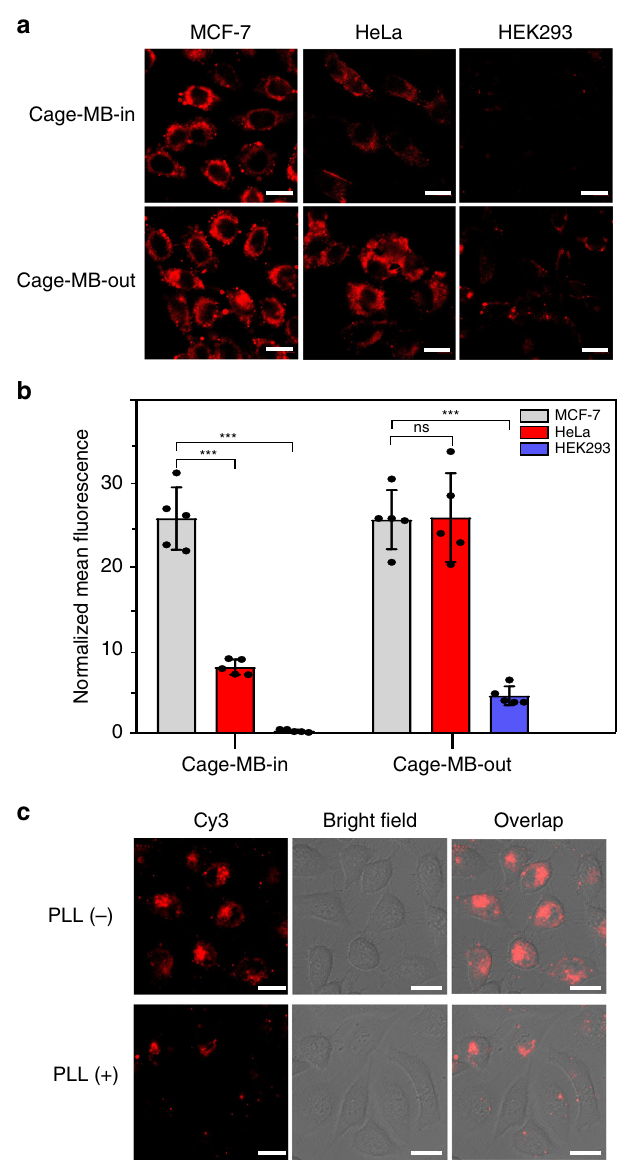
Fig. 7 Size-selective discrimination between mature microRNA and precursor microRNA in living cells. a , b Fluorescence confocal imaging of MCF-7, HeLa and HEK293 cells incubated with 100 nM Cage-MB-in and Cage-MB-out ( a ) and the normalized mean fl uorescence by ImageJ ( b ); Data are presented as mean values ± s.d. ( n = 5), *** p = 0.00000068 (0.000000036), 0.0000014 for HeLa (HEK293) to Cage-MB-in, HEK293 to Cage-MB-out < 0.001, ns = 0.93 > 0.05 (not signi fi cant), by two-tailed unpaired Student ’ s t -test. c Fluorescence confocal imaging of HeLa cells treated with and without 5 μ M miRNA-21 inhibitor PLL before incubating with 100 nM Cage-in. The scale bars are 20 μ m. Source data are provided as Source Data fi